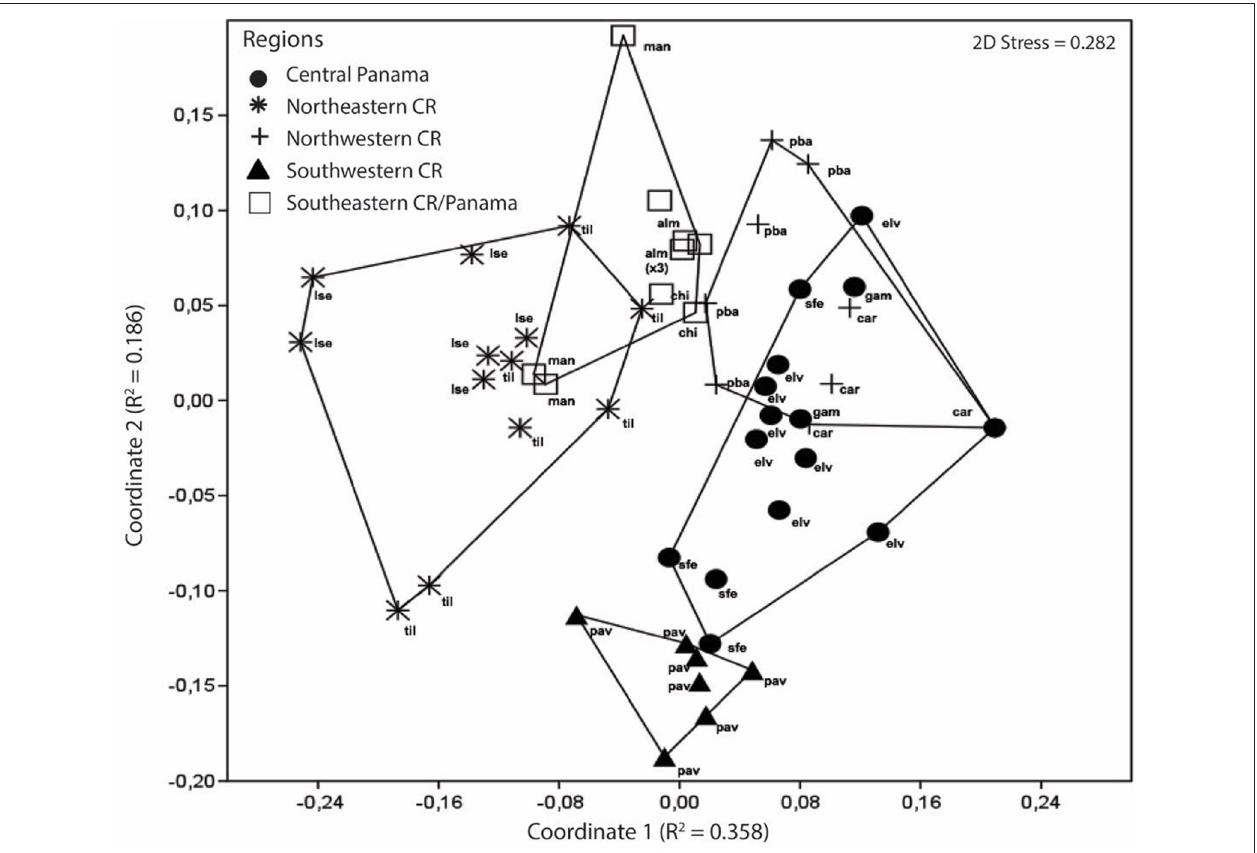
FIGURE 3 | Multidimensional scaling plot of peptide variation in A. callidryas from five phenotypically distinct biogeographical regions in Costa Rica and Panama. Each symbol represents an individual frog from a specific geographic region and the corresponding population of origin is annotated. The distance between symbols reflects the difference in peptide variation. On the basis of an analysis of similarity (ANOSIM), peptide variation is significantly different amongst each of the five regions (Global R = 0.52; P ≤